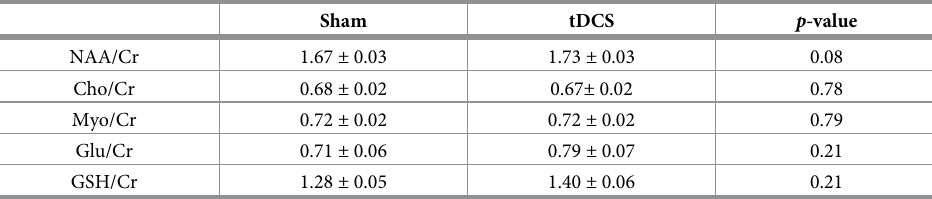
Table 2. Analysis of metabolic ratios: Metabolite ratios relative to total creatine. The p -values were calculated in post-hoc analysis of individual metabolite ratios using paired